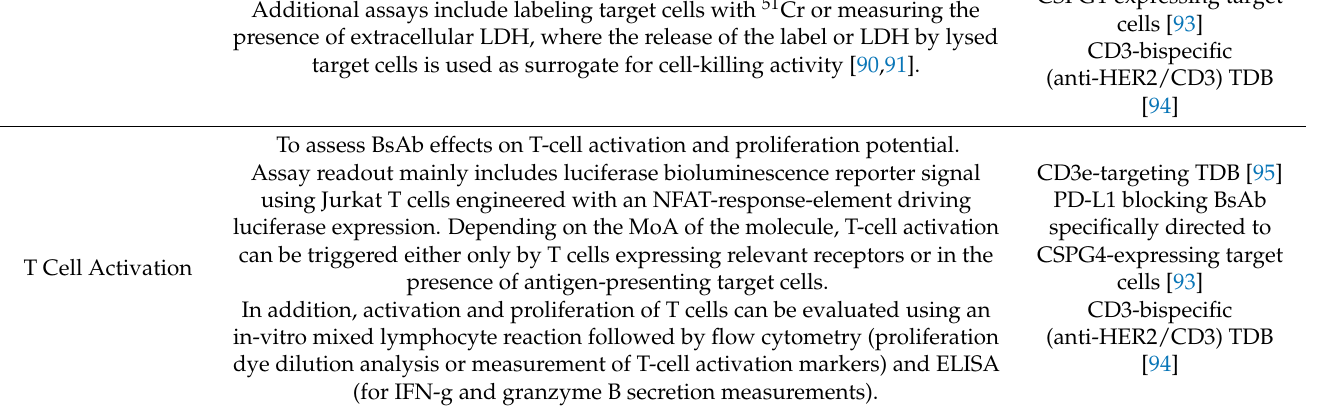
BsAbs: bispecific antibodies; ELISA: enzyme-linked immunosorbent assay; HRP: horseradish peroxidase; IFN-g: interferon gamma; LDH: lactate dehydrogenase; MoA: mechanism of action; NFAT: nuclear factor of activated T cells; SPR: surface-plasmon resonance; VH: variable heavy domain; Ang-2: angiopoietin-2; VEGF: vascular endothelial growth factor; PD-L1: programmed death-ligand 1; CSPG: chondroitin sulfate